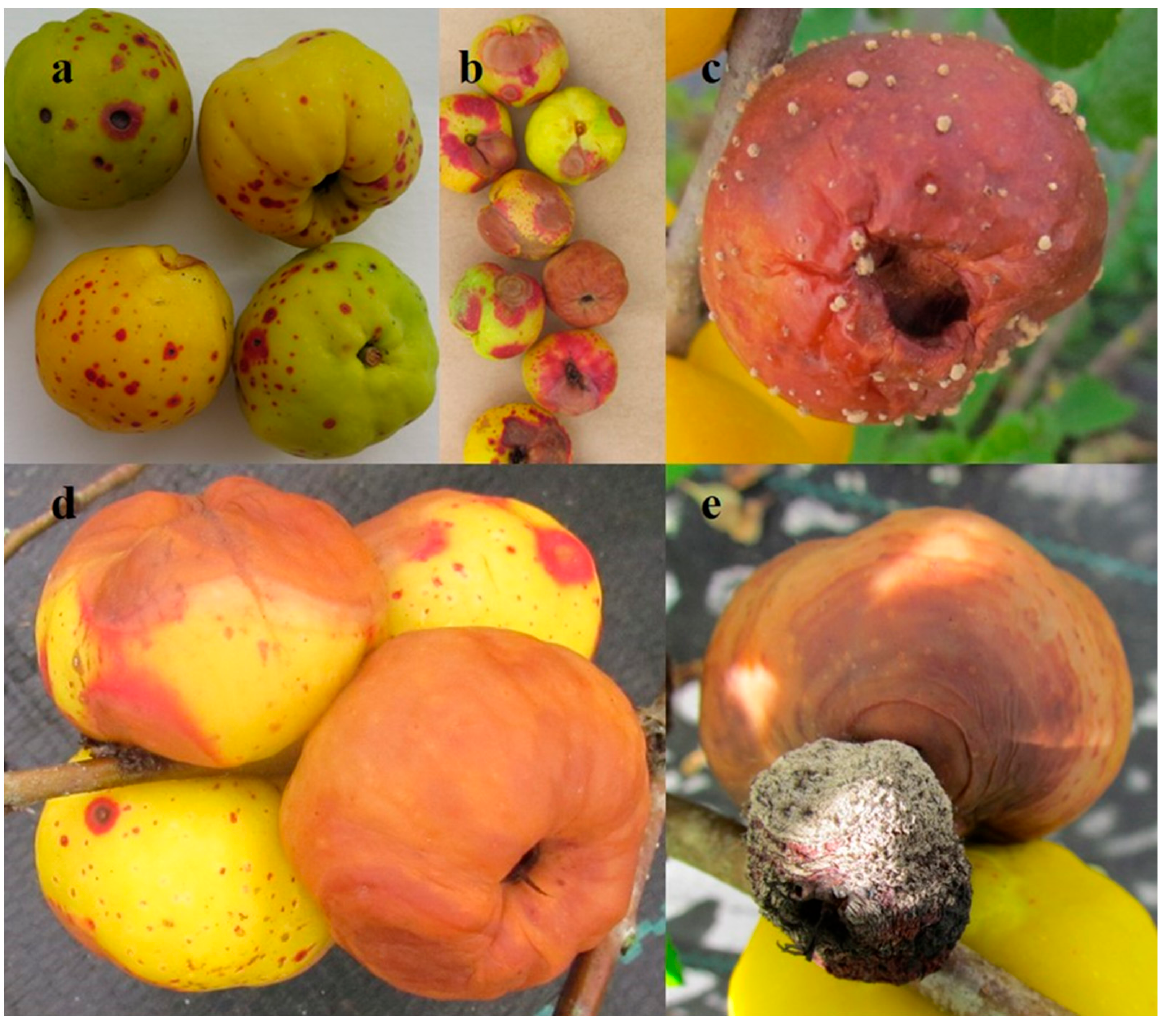
Figure 1 . Various leaf spots on Japanese quince leaves: ( a ) brown irregular spots with concentric rings; ( b ) dark brown necrotic spots; ( c ) small dark spots with red halo; ( d ) small fuzzy spots.